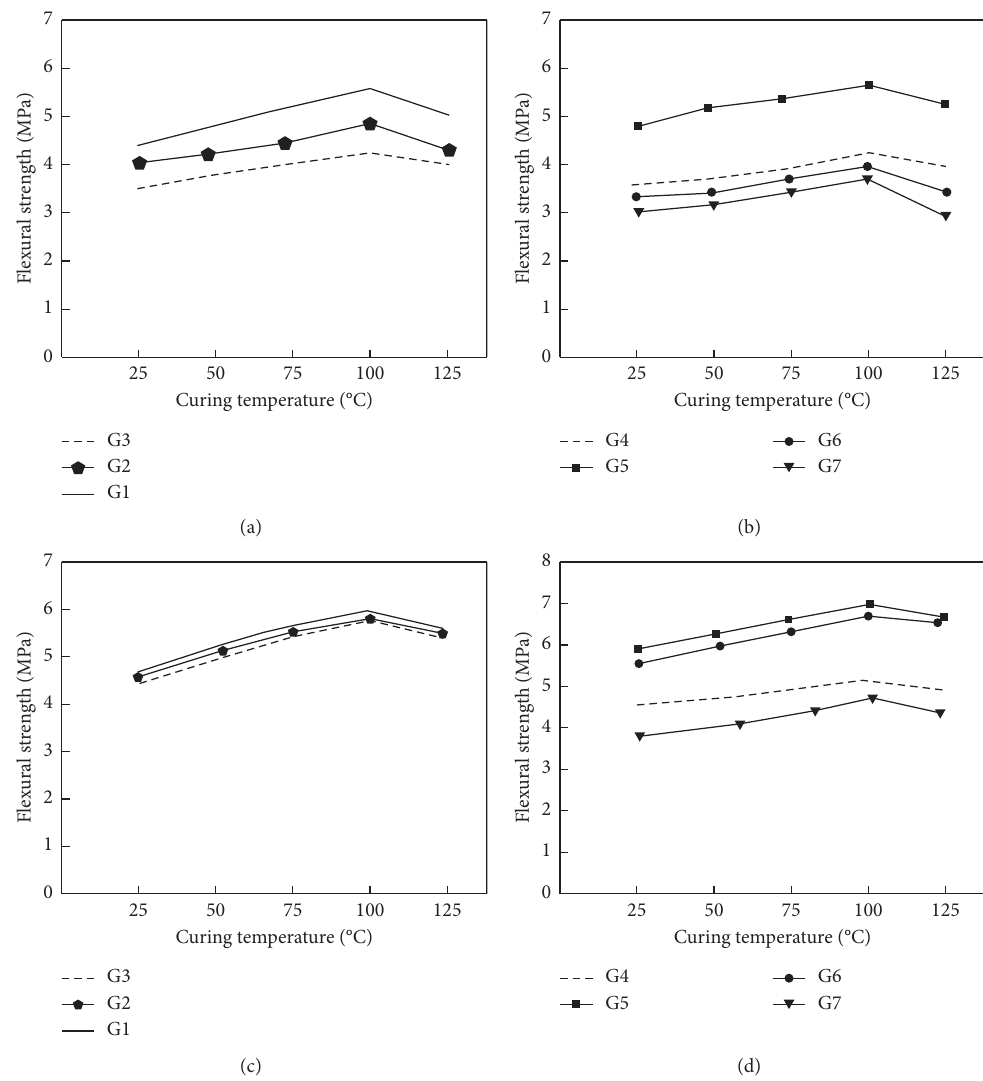
Figure 5: The variation of flexural strength of coal gangue-based polymer concrete with curing temperature. (a) Seven-day flexural